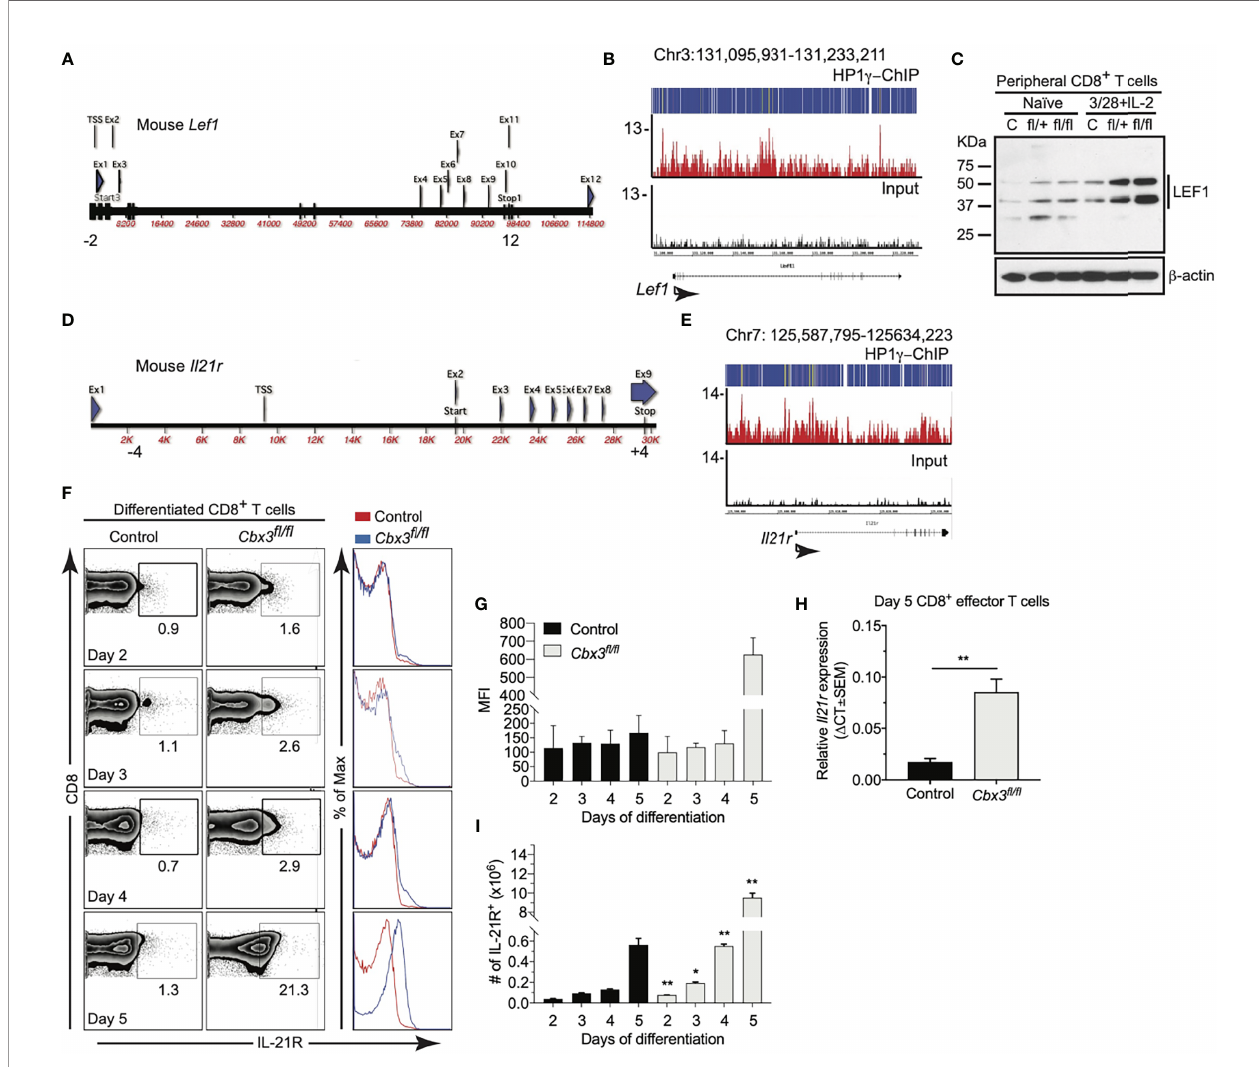
FIGURE 1 | Cbx3 /HP1 g de fi ciency modulates LEF-1 and IL-21R expression in CD8 + effector T cells. (A) Mouse Lef1 locus. -2 and 12: positions of fi rst and last primer pairs, respectively. (B) Read-density tracks of Cbx3 /HP1 g peaks across Lef1 identi fi ed by ChIP-Seq using chromatin from wt day 5 activated/differentiated CD8 + T cells (pooled from 3 mice); y axis: number of reads per million mapped per 25-bp window; representative of 2 independent ChIP-Seq runs. (C) LEF-1 expression was evaluated by Western immunoblot using total protein lysates from activated/differentiated control and Cbx3 /HP1 g -de fi cient CD8 + T cells; 3/28+IL2: CD8 + T cells activated/differentiated for 5 days with plate-bound anti-CD3 and anti-CD28 plus IL-2; C: control (CD8 a -Cre or wt); fl /+: Cbx3 fl /+ and fl / fl : Cbx3 fl / fl (CD8 + T-cell-restricted deletion of Cbx3/ HP1 g using the CD8 a -Cre mouse); n = 3; representative of 3 experiments. (D) Mouse Il21r locus. -4 and 4: positions of fi rst and last pair of primers, respectively. (E) Read-density tracks of Cbx3 /HP1 g peaks across Il21r were determined by ChIP-Seq as in (B) . (F) IL-21R expression levels on activated/differentiated CD8 + T cells by fl ow; numbers: percent cells; representative of 3 experiments; n = 3. (G) IL-21R mean fl uorescence intensity (MFI) was evaluated from (F) . (H) Relative expression of Il21r in day 5 activated/differentiated CD8 + T cells was assessed by RT-qPCR and normalized to Gapdh ; Graphpad unpaired student t-test: **p ≤ 0.01; representative of 3 experiments. (I) Number of CD8 + IL-21R + T cells in cultures was calculated from (F) ; Graphpad unpaired student t-test: *p ≤ 0.05, **p ≤